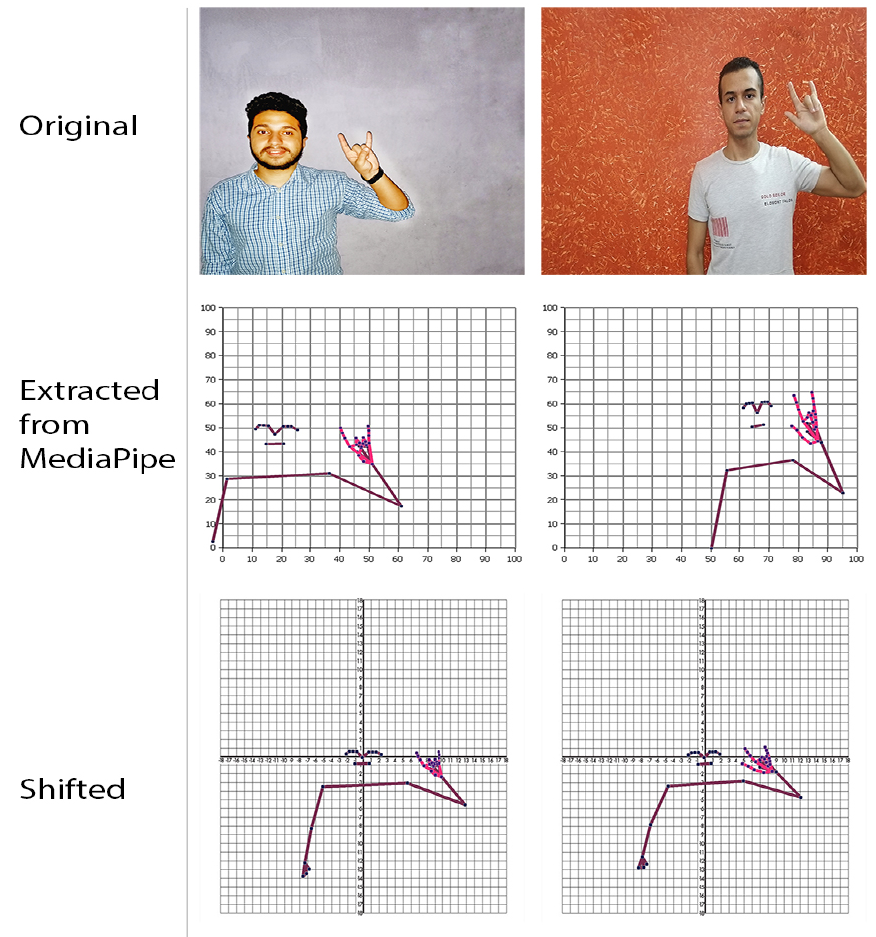
Figure 9. Relocation